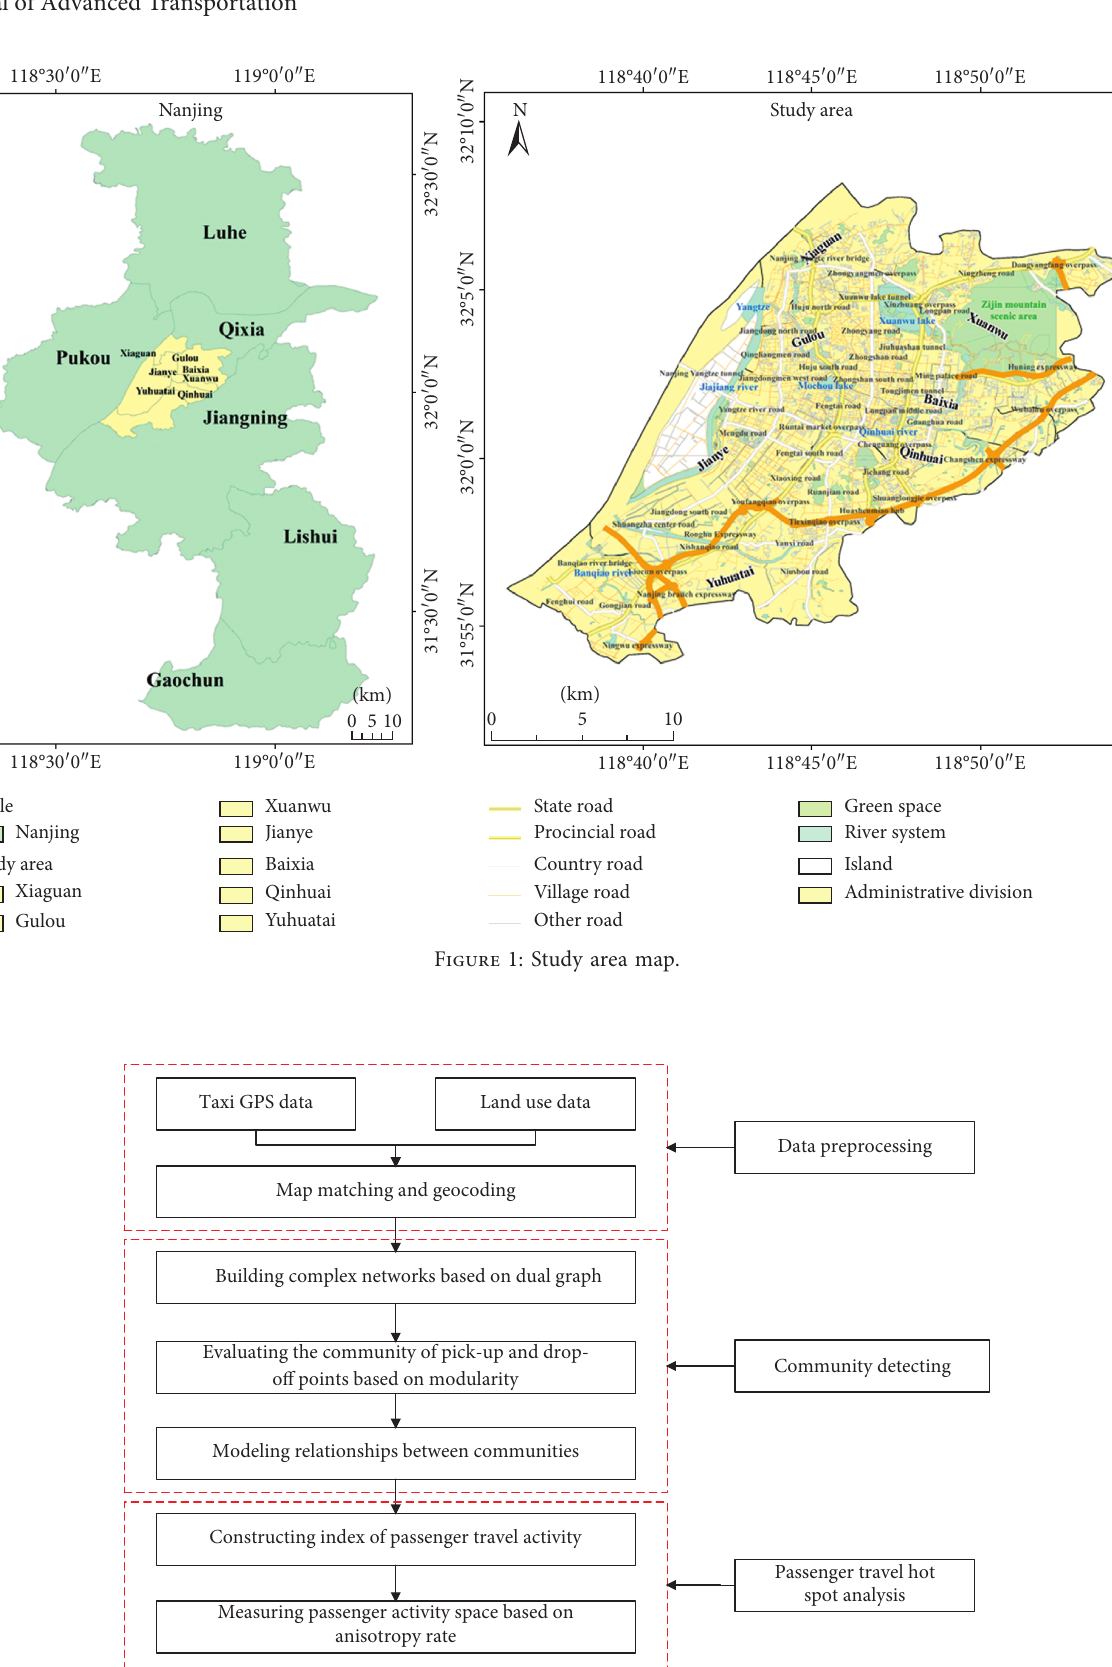
Figure 2: Technical